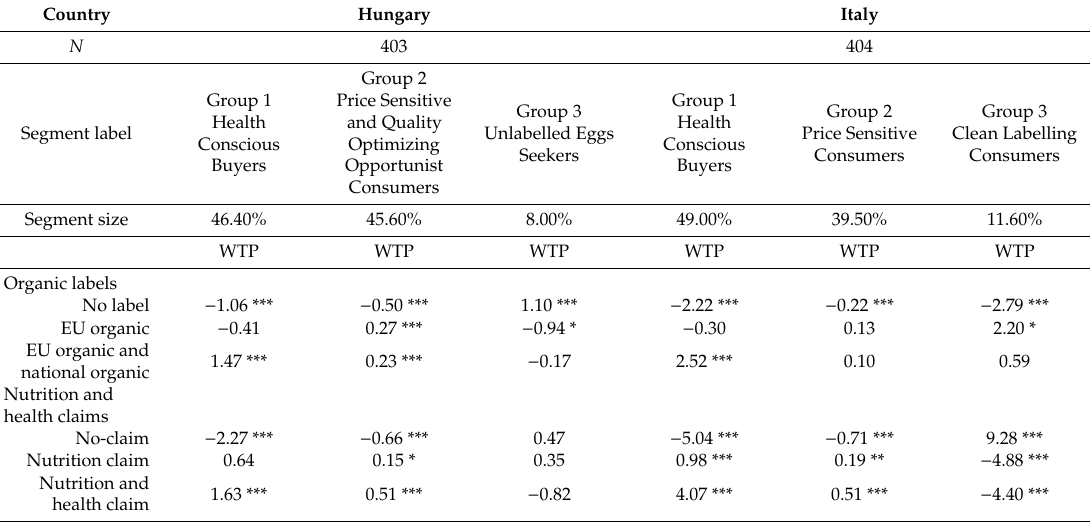
Table 7. Mean WTP estimates for cross-country latent consumer